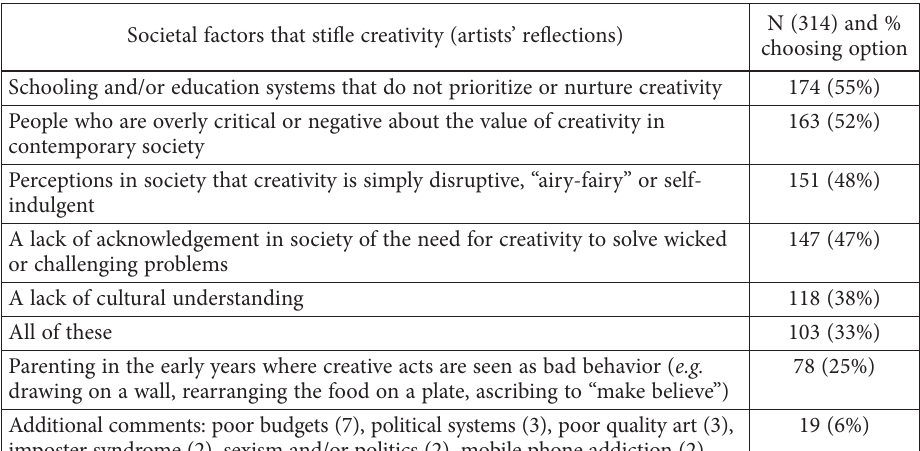
Table 6. Views on societal factors stifling creativity (source: created by author) Societal factors that stifle creativity (artists’ reflections) Schooling and/or education systems that do not prioritize or nurture creativity 174 (55%) People who are overly critical or negative about the value of creativity in contemporary society